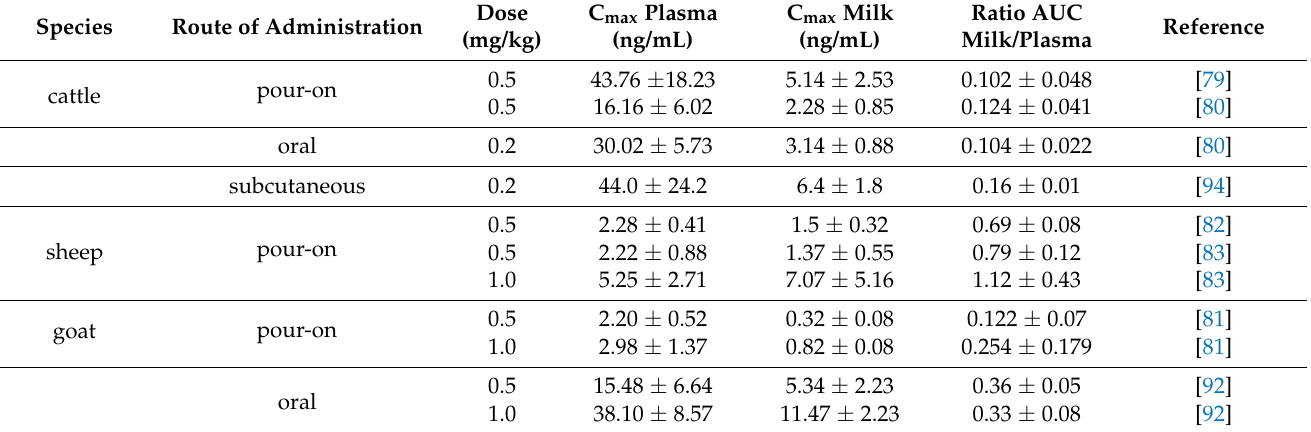
C max : peak plasma or milk concentration; AUC: area under the concentration vs. time curve where the drug was